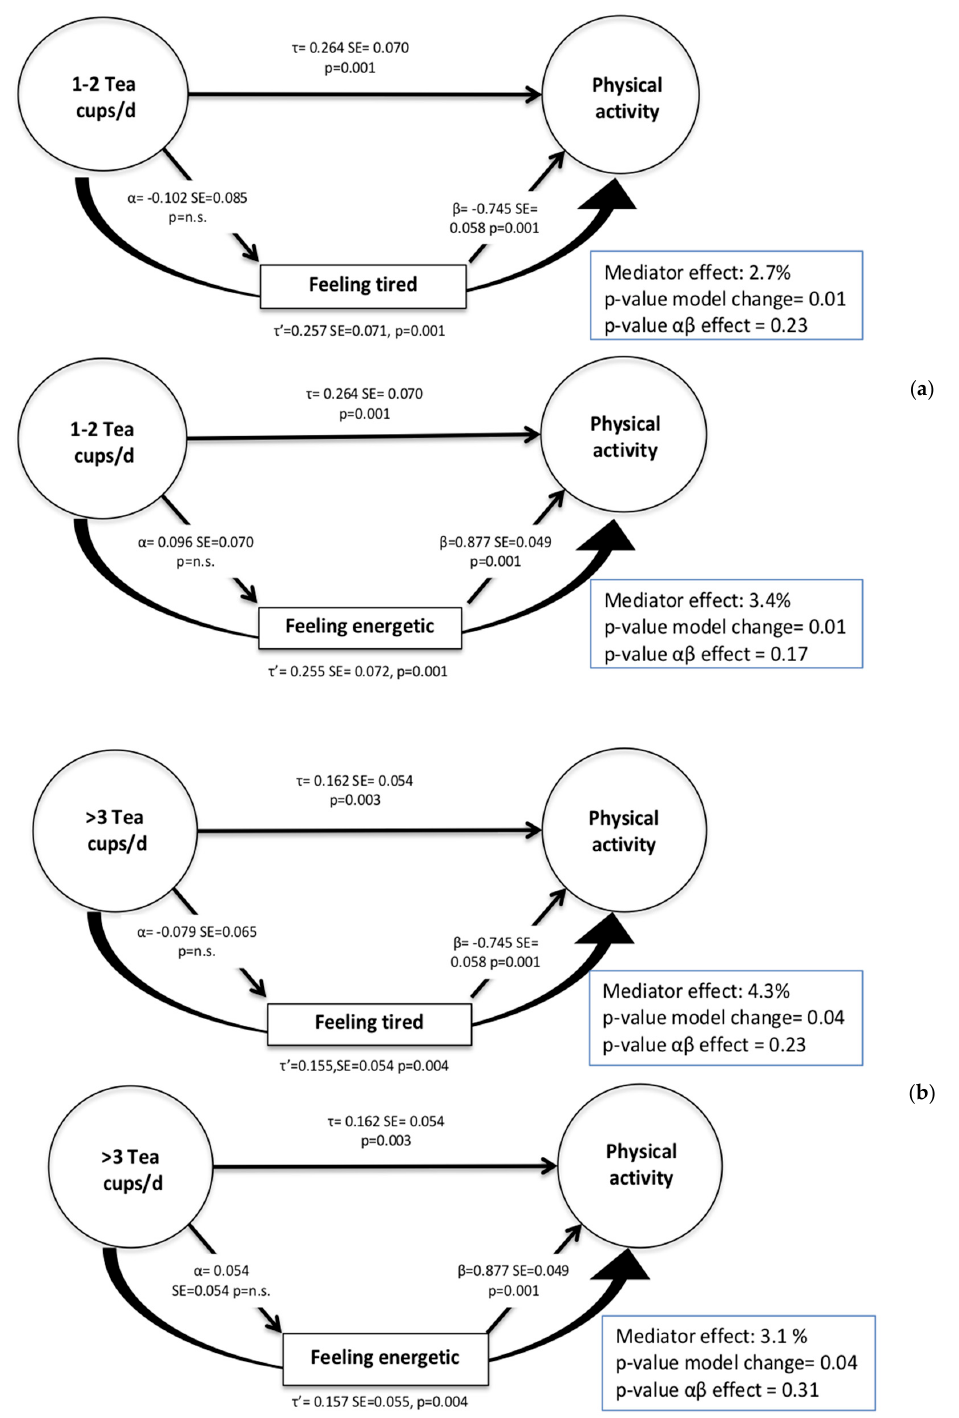
Figure 2. Mediation analysis for the relationship between coffee consumption and meeting physical activity guidelines ( a ) 1–2 cups of tea/day and ( b ) >3 cups of tea/day, with correlation coefficients